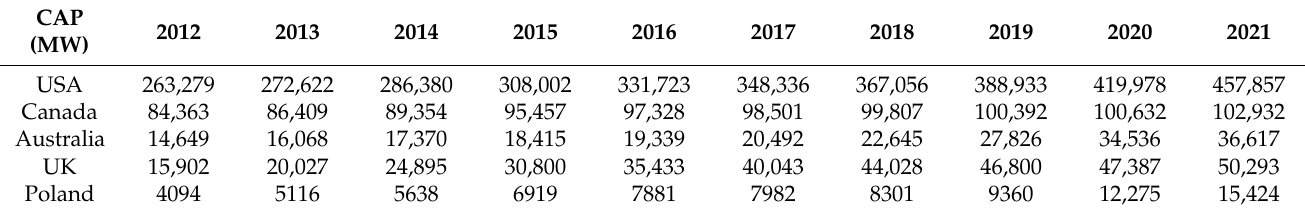
Table 1. Total renewable energy in the countries selected for